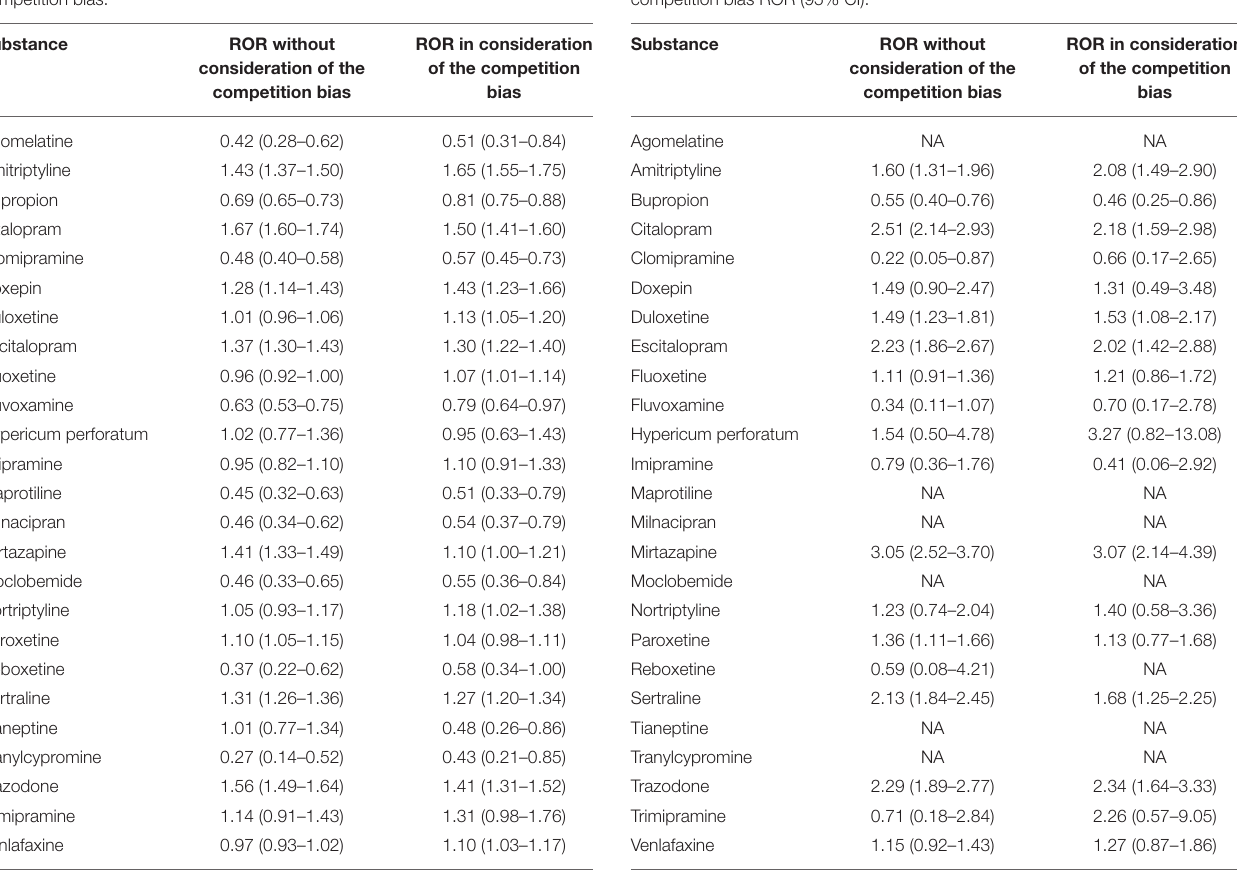
TABLE 3 | Reporting odds ratios and 95% CIs related to antidepressants and the PT “Upper gastrointestinal haemorrhage” with and without consideration of the competition bias ROR (95%